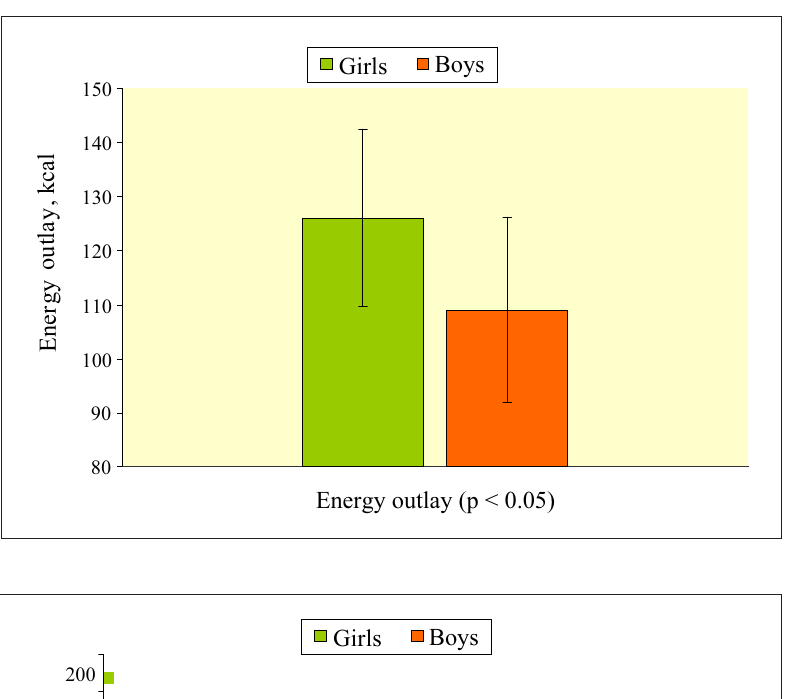
Figure 4. The indices of the heart rate for juvenile sports dancers during Latin American Figure 5. Energy outlay (kcal) for juvenile sports dancers in Latin American dances